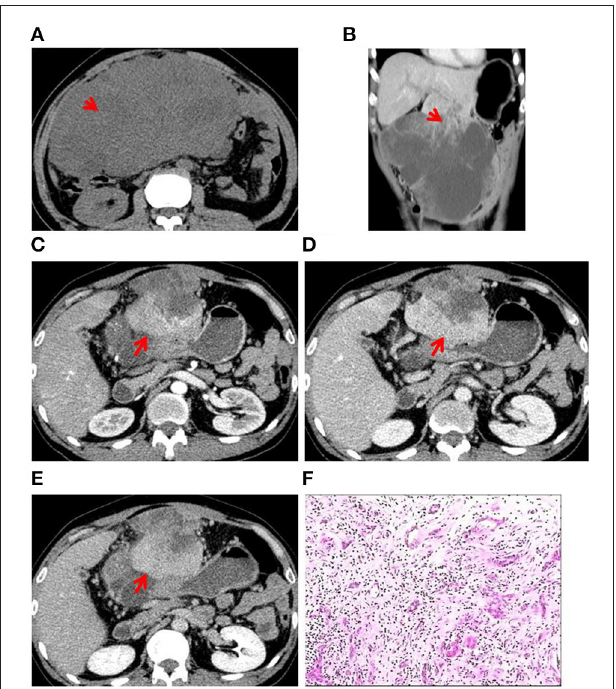
FIGURE 1 | Case 1: A 52-year-old man presented with upper abdominal pain since 3 months. (A) CT scan showed heterogeneously hypo-dense lesions (red arrow). (B) A large exogenous mass in the S3 segment of the liver was observed with irregular thick-walled areas inside the lesion (red arrow). (C) Contrast-enhanced CT in the arterial phase showed uneven mild to moderate enhancement of the lesion with intratumoral vessels and that the tumor has invaded the anterior abdominal wall (red arrow). (D) CT scan in the portal-vein phase showed gradual filling of the lesion from the edge to the center (red arrow). (E) CT scan in the prolongation phase showed gradual filling of the lesion from the edge to the center (red arrow). (F) Histopathological examination of surgical specimen: the carcinomatous component (cholangiocarcinoma) is interspersed with the sarcomatous component (angiosarcoma).